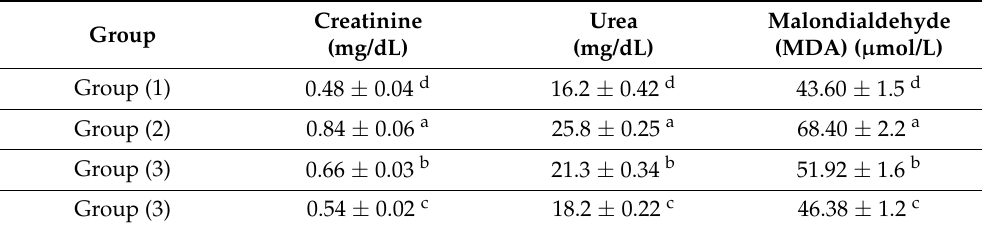
Table 7. Effect of fermented camel milk containing pumpkin seed milk on kidney function and oxidative stress markers in experimental rats.